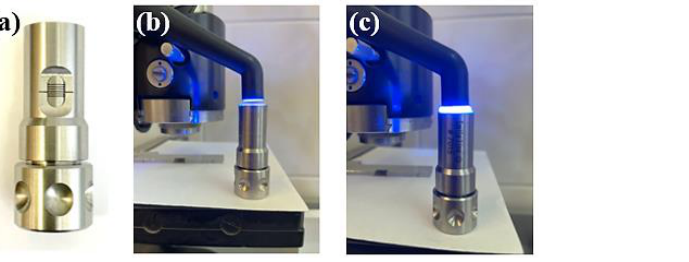
Figure 1. ( a ) The Porcelain Sampler device; ( b , c ) the light curing process using Demi Ultra Kit Cordless Light Curing Lamp–Kerr for 20 s.